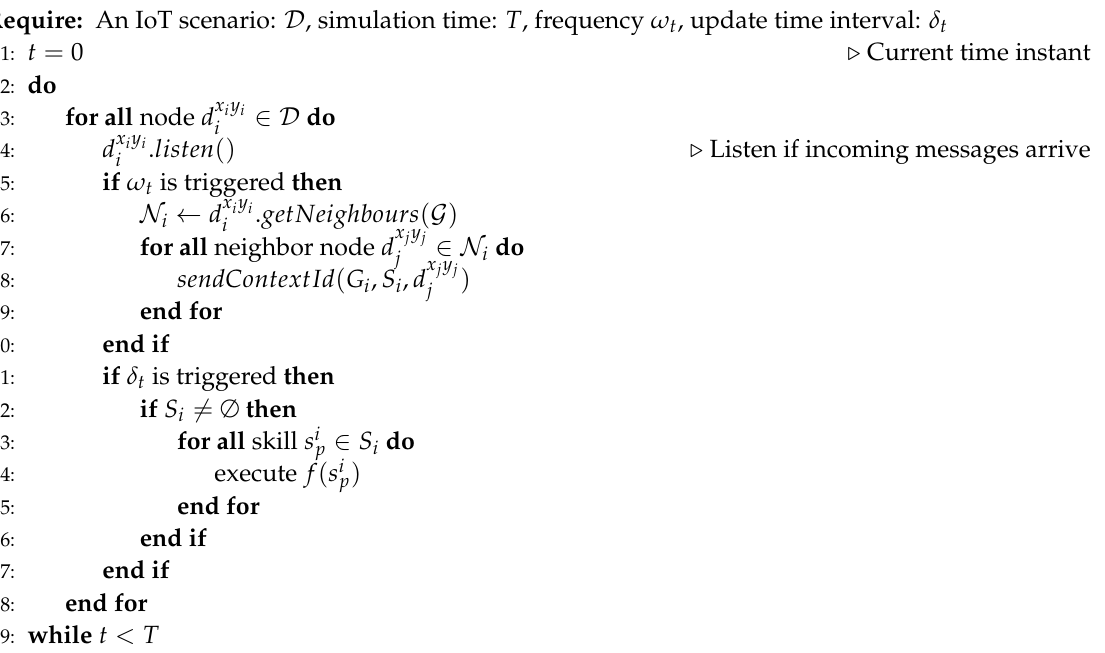
Algorithm 1 SACAR pseudocode description (i): share context IDs and skills’ execution.